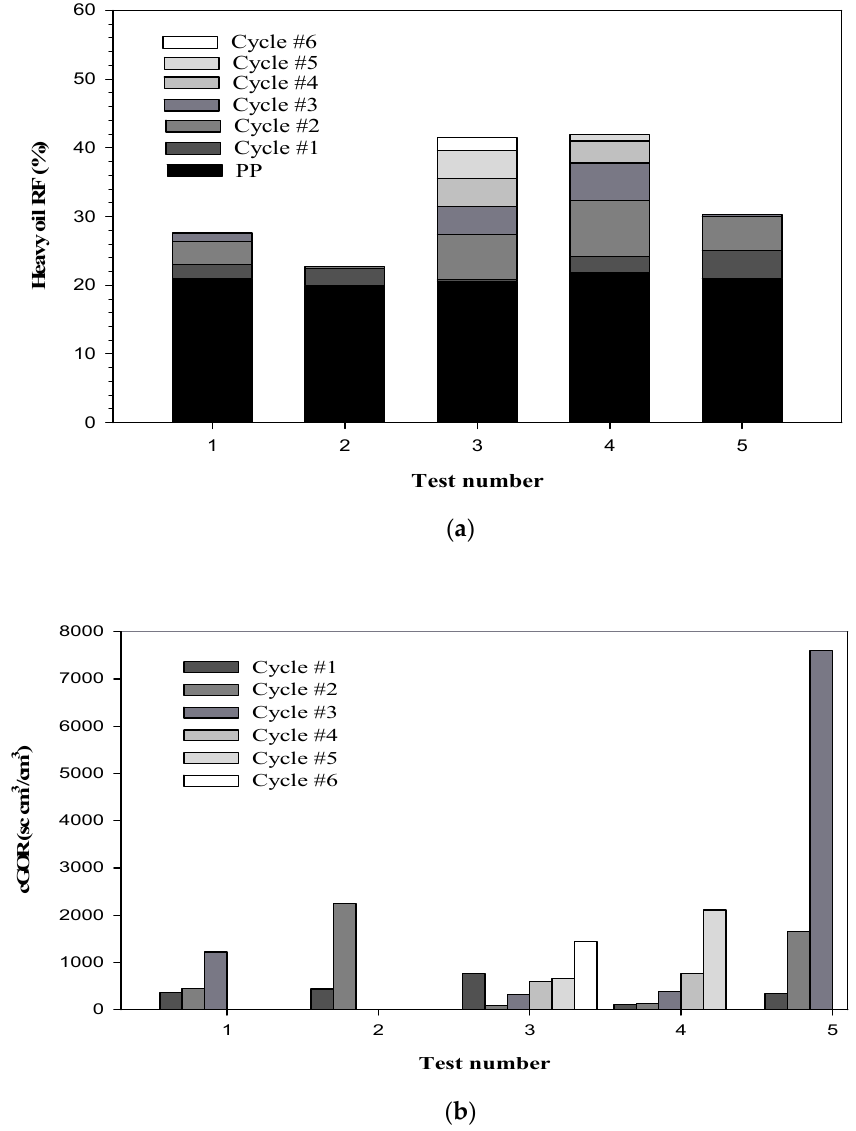
Figure 10. ( a ) Measured heavy oil recovery factors (RFs) during the primary productions (PPs) at the final primary production pressures of P f = 0.2 MPa and the different cycles in Tests #1–5. ( b ) Measured cumulative gas ‒ oil ratio (cGORs) during Cycles #1 ‒ 3 in C 3 H 8 -CSI process at ∆ P EOR = 0.5 MPa (Test #1); Cycles #1 ‒ 2 in CO 2 -CSI process at ∆ P EOR = 0.5 MPa (Test #2); different cycles in C 3 H 8 -GPC processes at ∆ P EOR = 0.1 and 0.5 MPa (Tests #3 and #4); and Cycles #1–3 in CO 2 -GPC process at ∆ P EOR = 0.5 MPa (Test #5).